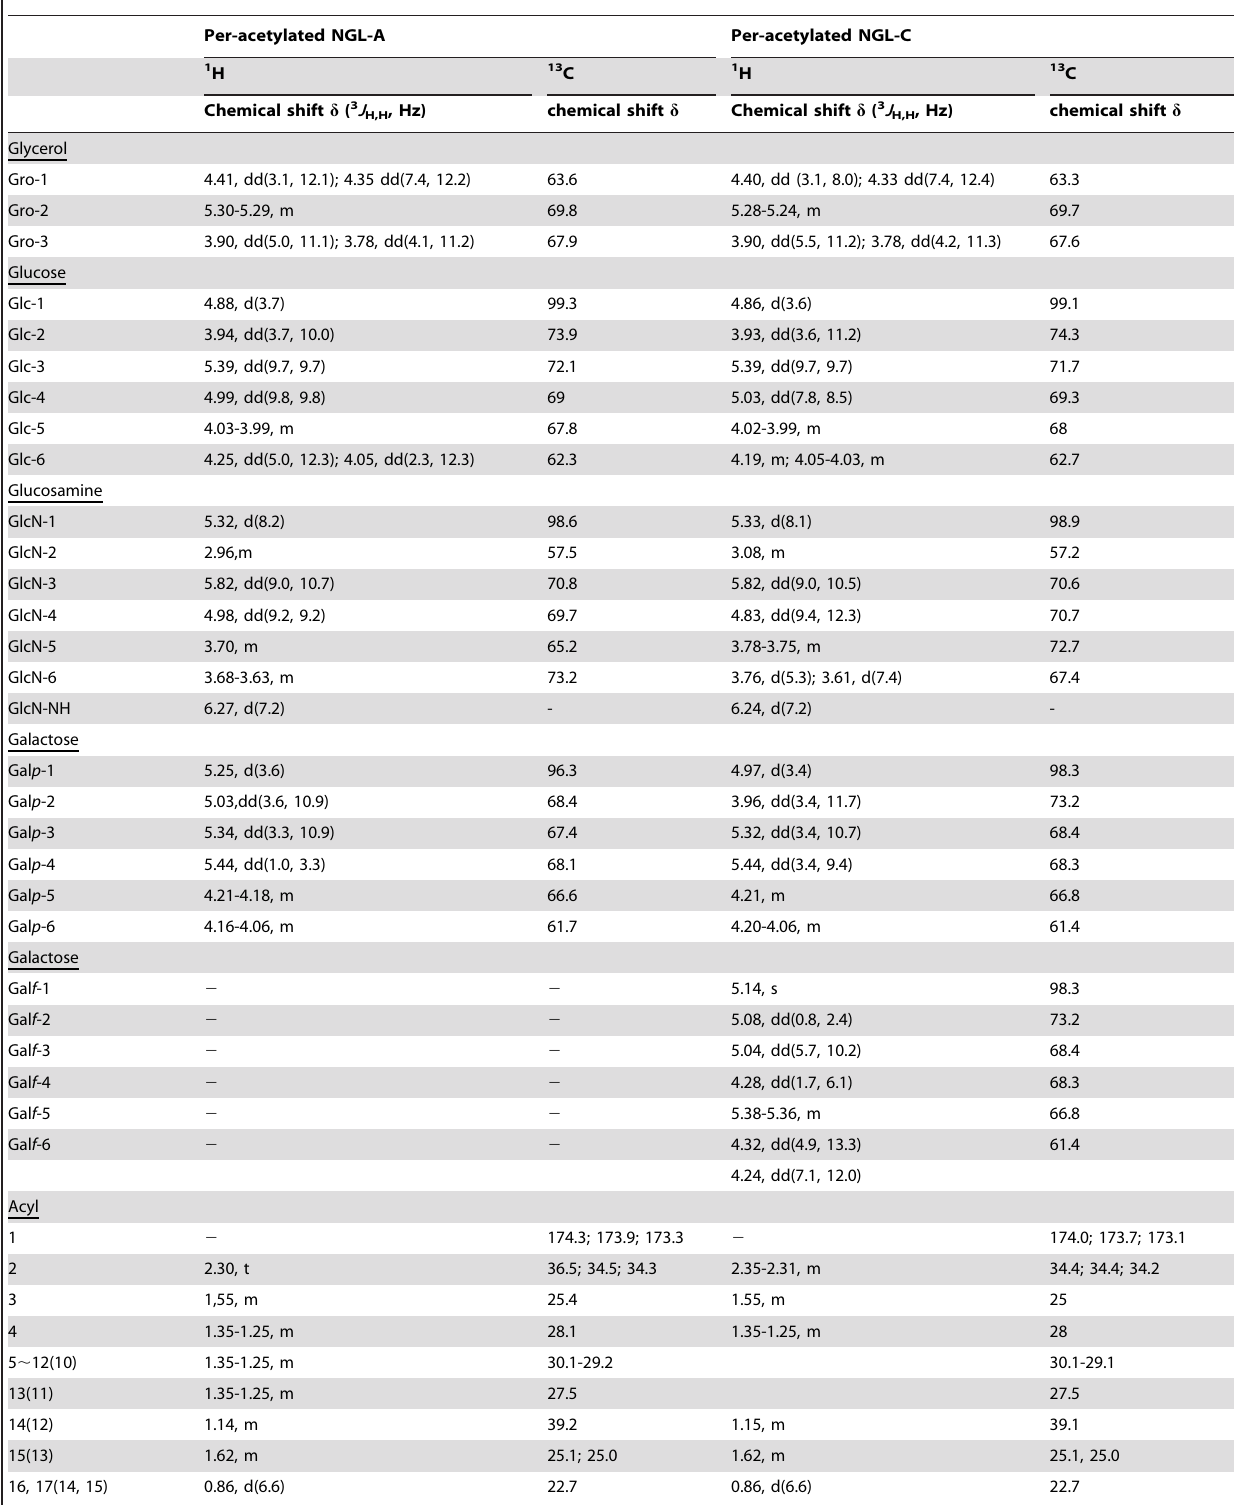
Table 3. NMR data of per-acetylated neutral glycolipids extracted from T. thermophilus HB8.